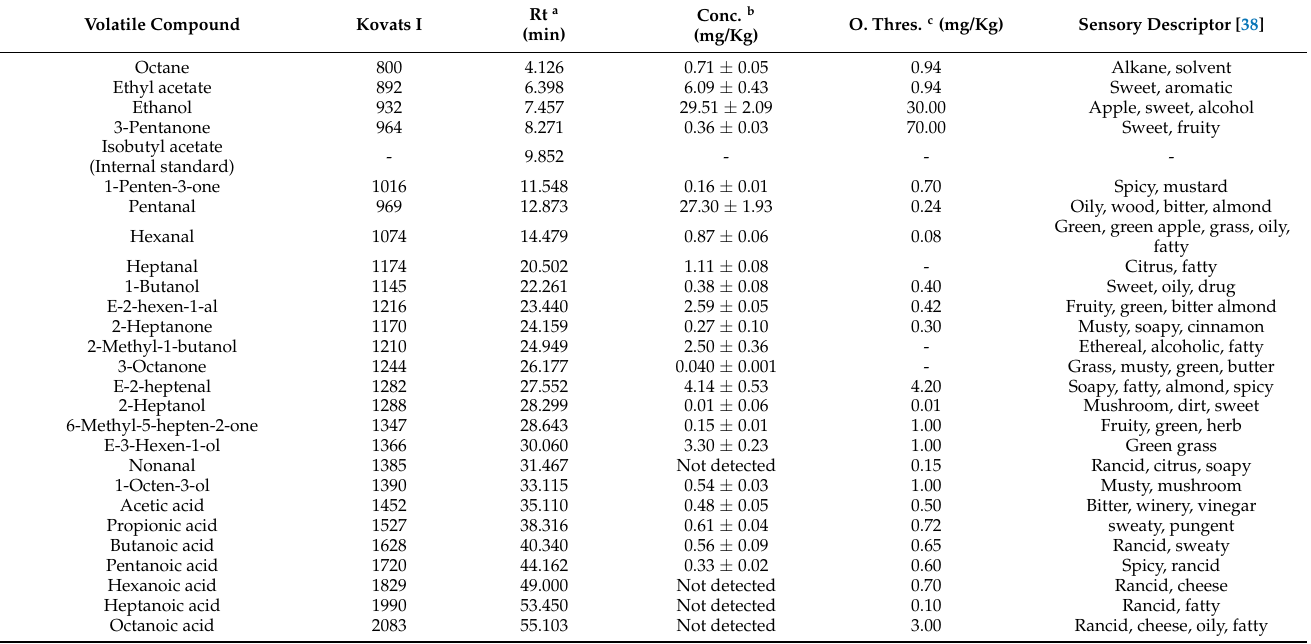
Table 1. Kovats index, retention time (min), concentration (mg/Kg), odor threshold (mg/Kg) and sensory descriptors of the volatile compounds of the sample